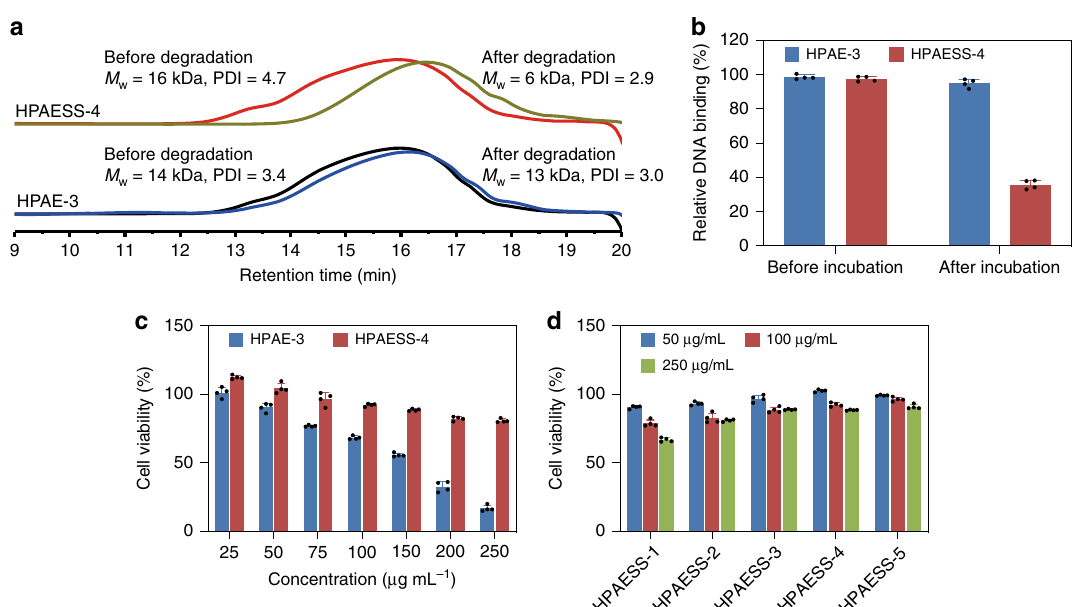
Fig. 4 Enhanced biodegradability bene fi ts DNA release and low cytotoxicity. a GPC traces of HPAE-3 and HPAESS-4 before and after incubation with 10mM GSH show that the HPAESS-4 can be degraded quickly by GSH. b The relative DNA binding af fi nity of HPAESS-4 decreased signi fi cantly after incubation with 10mM GSH, indicating its enhanced degradability by the integrated disul fi de bonds in the backbone. c At a series of polymer concentrations, cell viability of primary astrocytes incubated with HPAESS-4 was much higher than that with HPAE-3. d At a series of polymer concentrations, cell viability of primary astrocytes increased with the content of disul fi de bonds in polymer backbones. Data are shown as average ±SD; n =